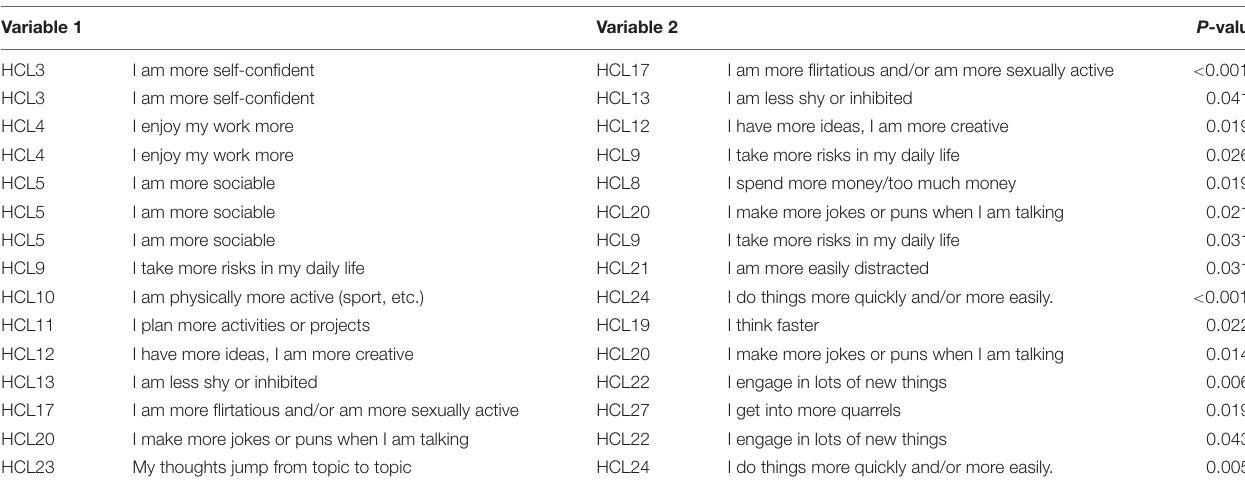
FIGURE 1 | Network structure of hypomanic symptoms in individuals with bipolar I/II disorders. TABLE 2 | Edge differences between BD-I and BD-II